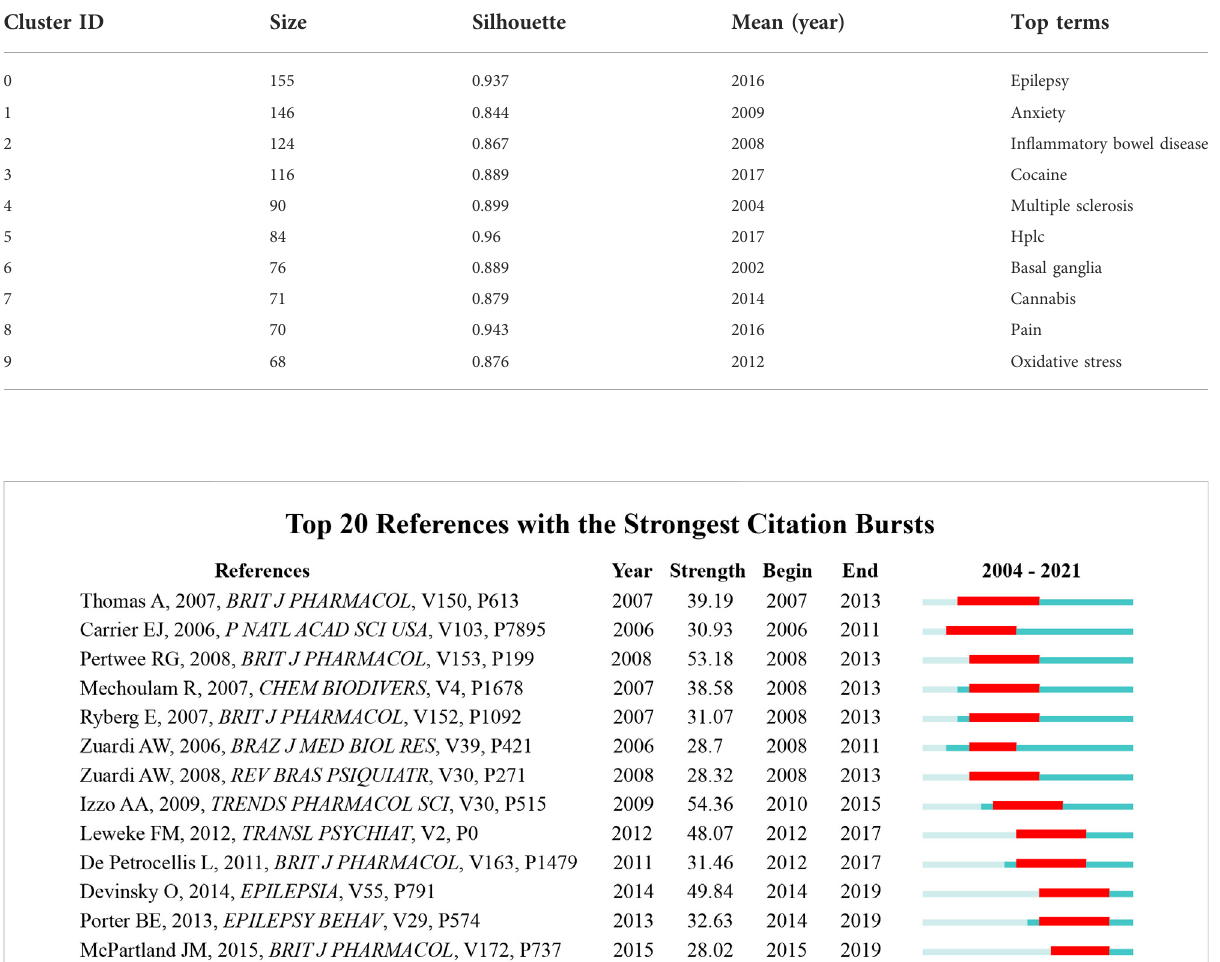
TABLE 5 The detailed information of 10 clusters in Figure 5C.